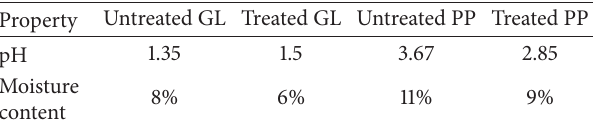
Table 1: Characteristics of adsorbents.